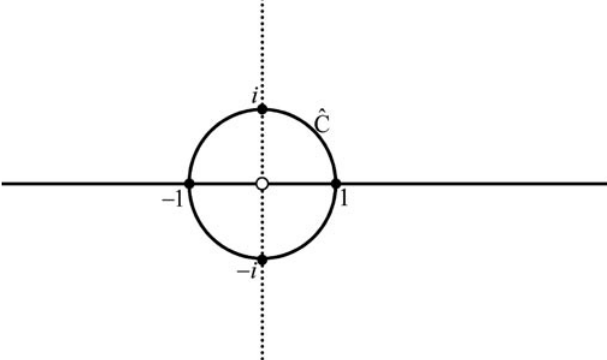
Figure 1 All possible eigenvalues of transferences in the complex plane. The eigenvalues lie on the real line excluding ^ ^ 0 and on the unit circle C . The horizontal line represents the real numbers from the negative numbers on the left to the posi- tive numbers on the right. 0 is at the origin and – 1 and 1 are marked. The vertical dotted line represents the imaginary num- bers; i , that is  – 1, and – i are marked. Points not on the real or imaginary number lines represent complex numbers